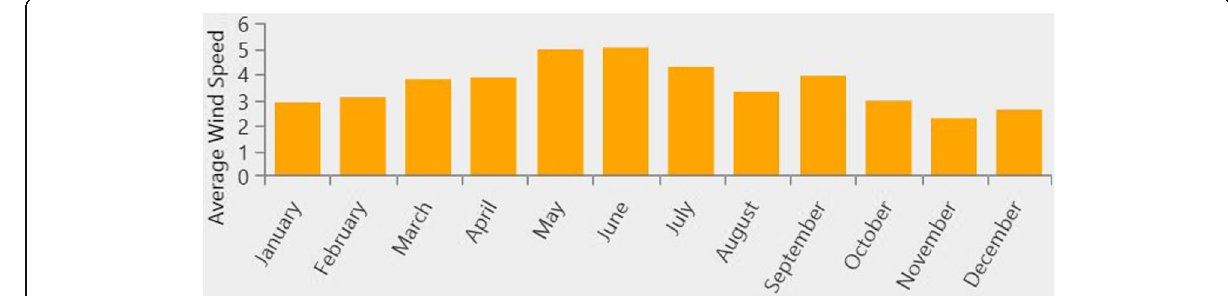
Fig. 6 Variation in monthly average wind speed data